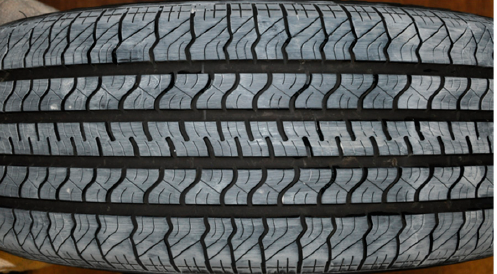
Figure 15. Tread pattern of SRTT (tread surface is white painted).